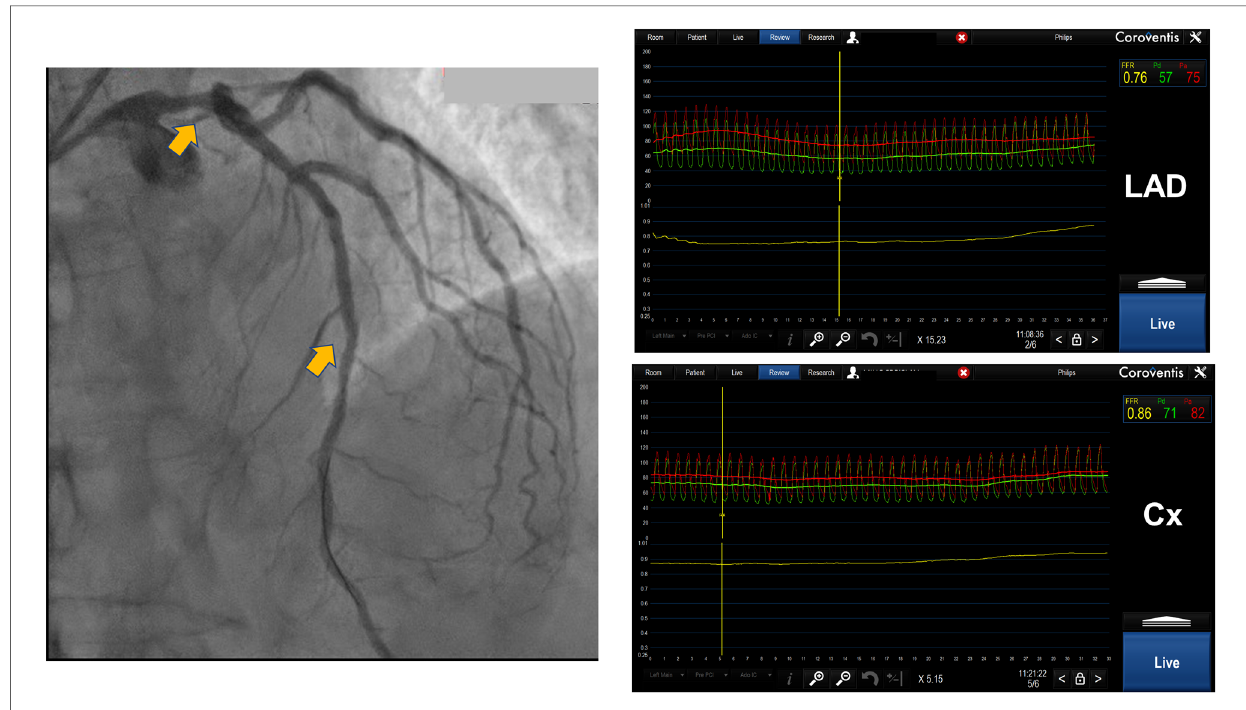
FIGURE 3 Distal left main lesion evaluation with downstream stenosis in LAD using Coroventis CoroFlow cardiovascular software (Coroventis AB, Uppsala, Sweden). Placing a pressure sensor in distal LAD FFR 0.76 was acquired while placing a sensor in distal Cx, free from disease, obtained FFR was 0,86. The lesion of distal LM was deemed insigni fi